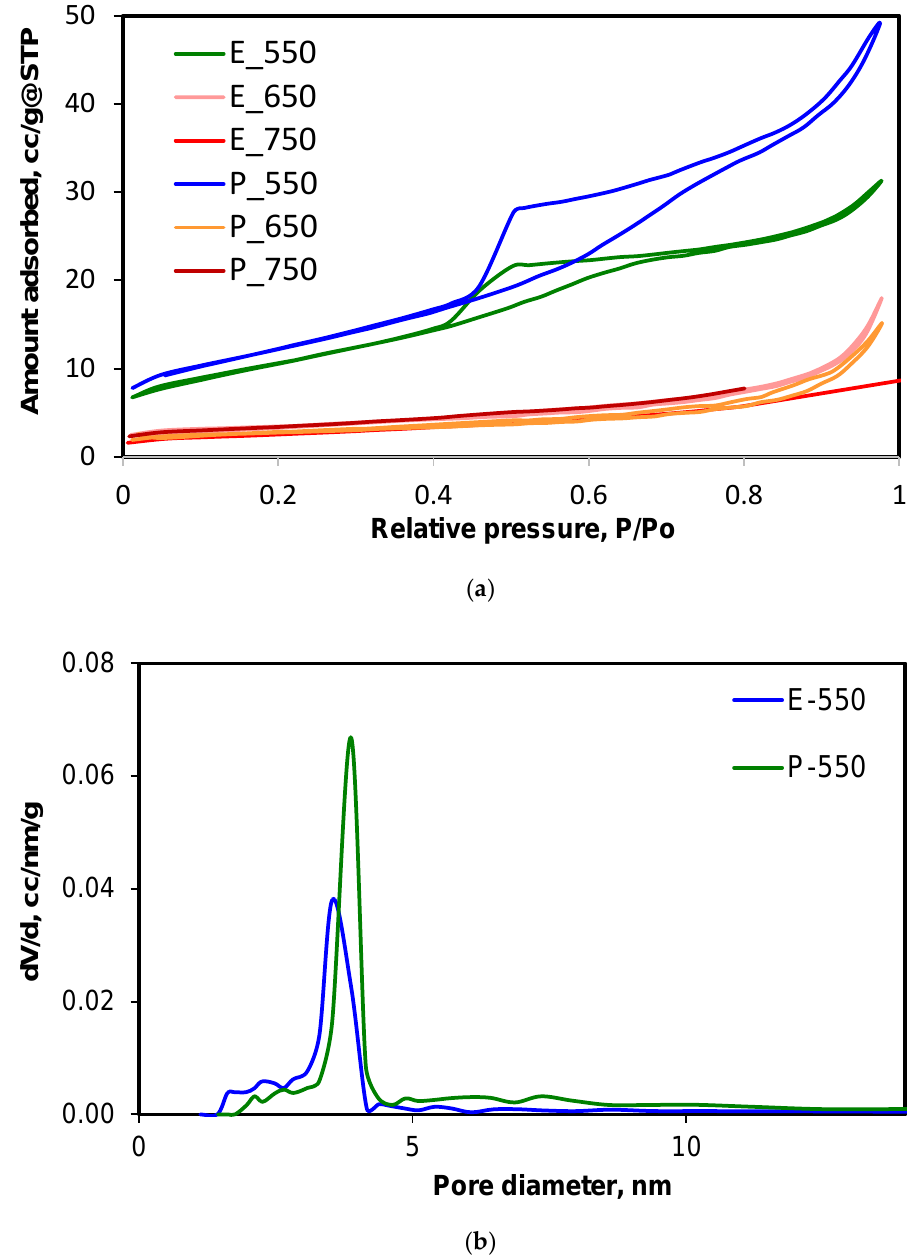
Figure 4. ( a ) Nitrogen adsorption isotherms at 77 K; ( b ) pore size distribution for samples E-550 and P-550. Table 4. Textural properties of the samples calculated from the nitrogen adsorption isotherms *.